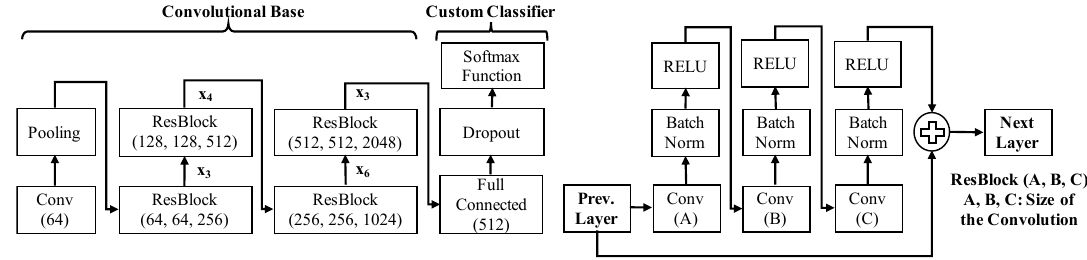
Figure 8. Architecture of the ResNet50 Network.